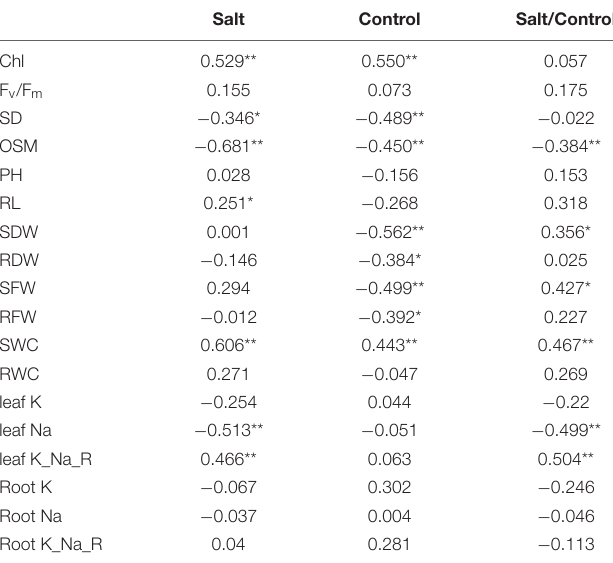
TABLE 4 | Coefficients of the agro-physiological traits with a significant contribution to STI.